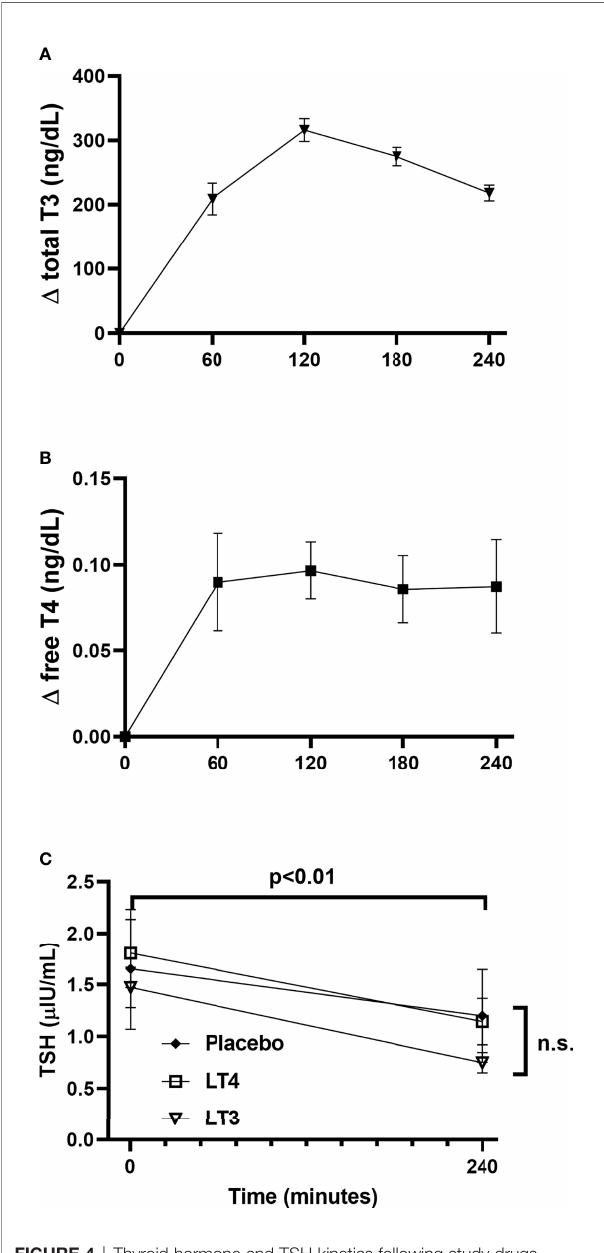
FIGURE 4 | Thyroid hormone and TSH kinetics following study drugs administration. (A) changes in total T3 concentration from baseline following LT3 administration. (B) changes in free T4 concentration from baseline following LT4 administration. (C) TSH concentrations at baseline and 240 ’ following administration of LT3, LT4, and placebo. Data are presented as mean ± SEM. ns, not signi fi cant.